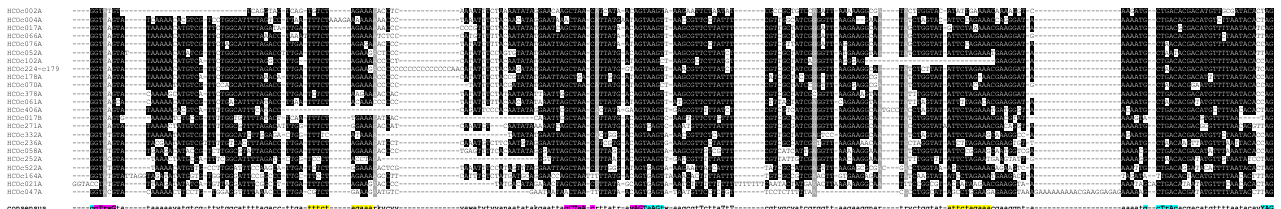
Figure 2. Alignment of 23 (D1,2) sister stwintrons from Hypoxylon sp. CO27-5. 23 (D1,2) stwintrons with high global sequence similarity were collected by BLASTN screening of the genome sequences of Hypoxylon sp. CO27-5 (GenBank MDCL00000000: 580 contigs) with the (D1,2) stwintron in a conserved mitochondrial carrier gene (stwintron HCOc017A) as the query. The sequence of stwintron HCOc224-179 and the gene harbouring it ( duf636 ) was determined experimentally (GenBank Accession MW477887). The full-length intronic sequences were aligned by Multiple Sequence Alignment (MAFFT) using E-INS-i iterative refinement and the 20PAM scoring matrix without sequence trimming. The consensus line was annotated with IUPAC symbols for combinations of bases occurring on each of the 276 positions, except for the apparent insertions that had occurred in only one or two sequences. 5 (cid:48) -Donor-, (predicted) BP- and 3 (cid:48) acceptor sequences are highlighted in colour—magenta for the internal intron and turquoise for the external intron. The two copies of a 10-nt palindrome (5 (cid:48) -WTTCTAGAAA) are highlighted in yellow